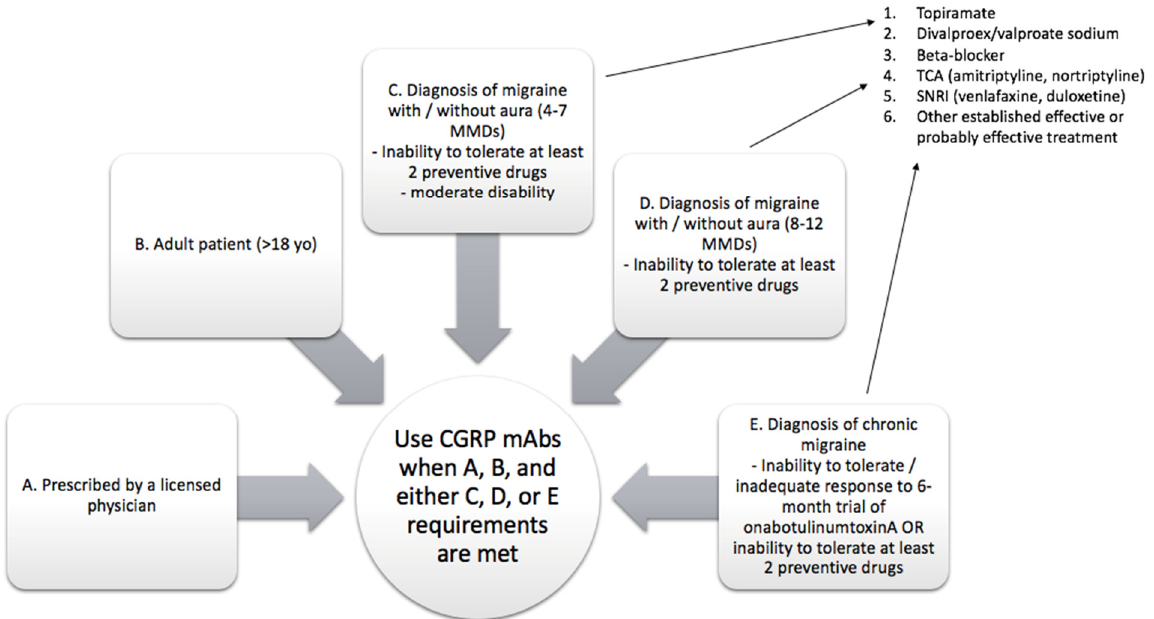
Figure 2. Criteria for starting a preventive treatment with anti-CGRP mAbs, according to the classification of migraine as defined by the International Classification of Headache Disorders, 3rd edition. CGRP: calcitonin-gene related peptide; MMDs: monthly migraine days; SNRI: serotonin norepinephrine reuptake inhibitors; TCA: tricyclic antidepressants.